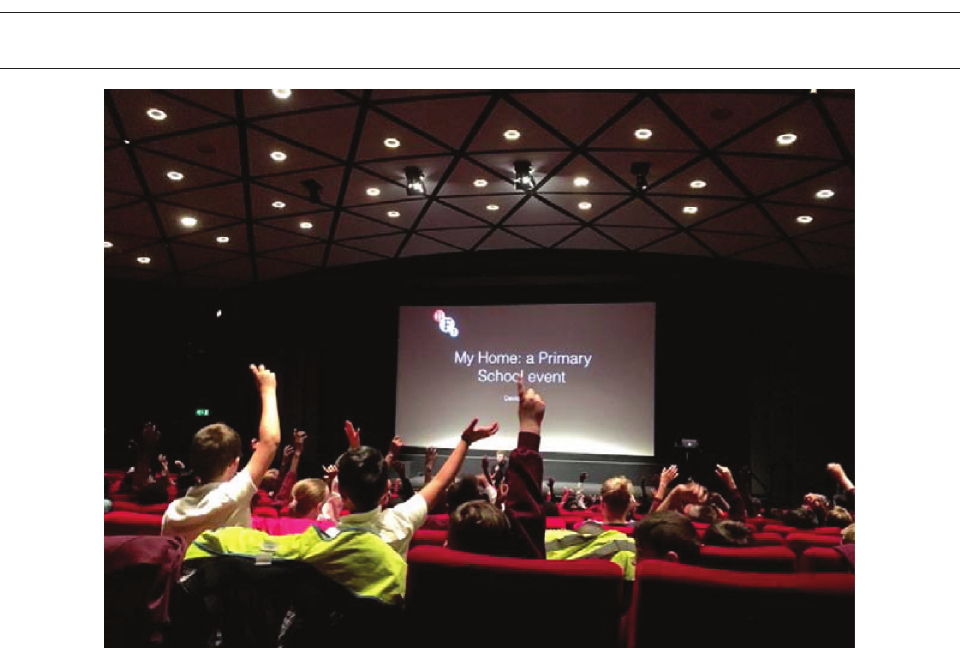
Figure 2: Screening films on the topic of